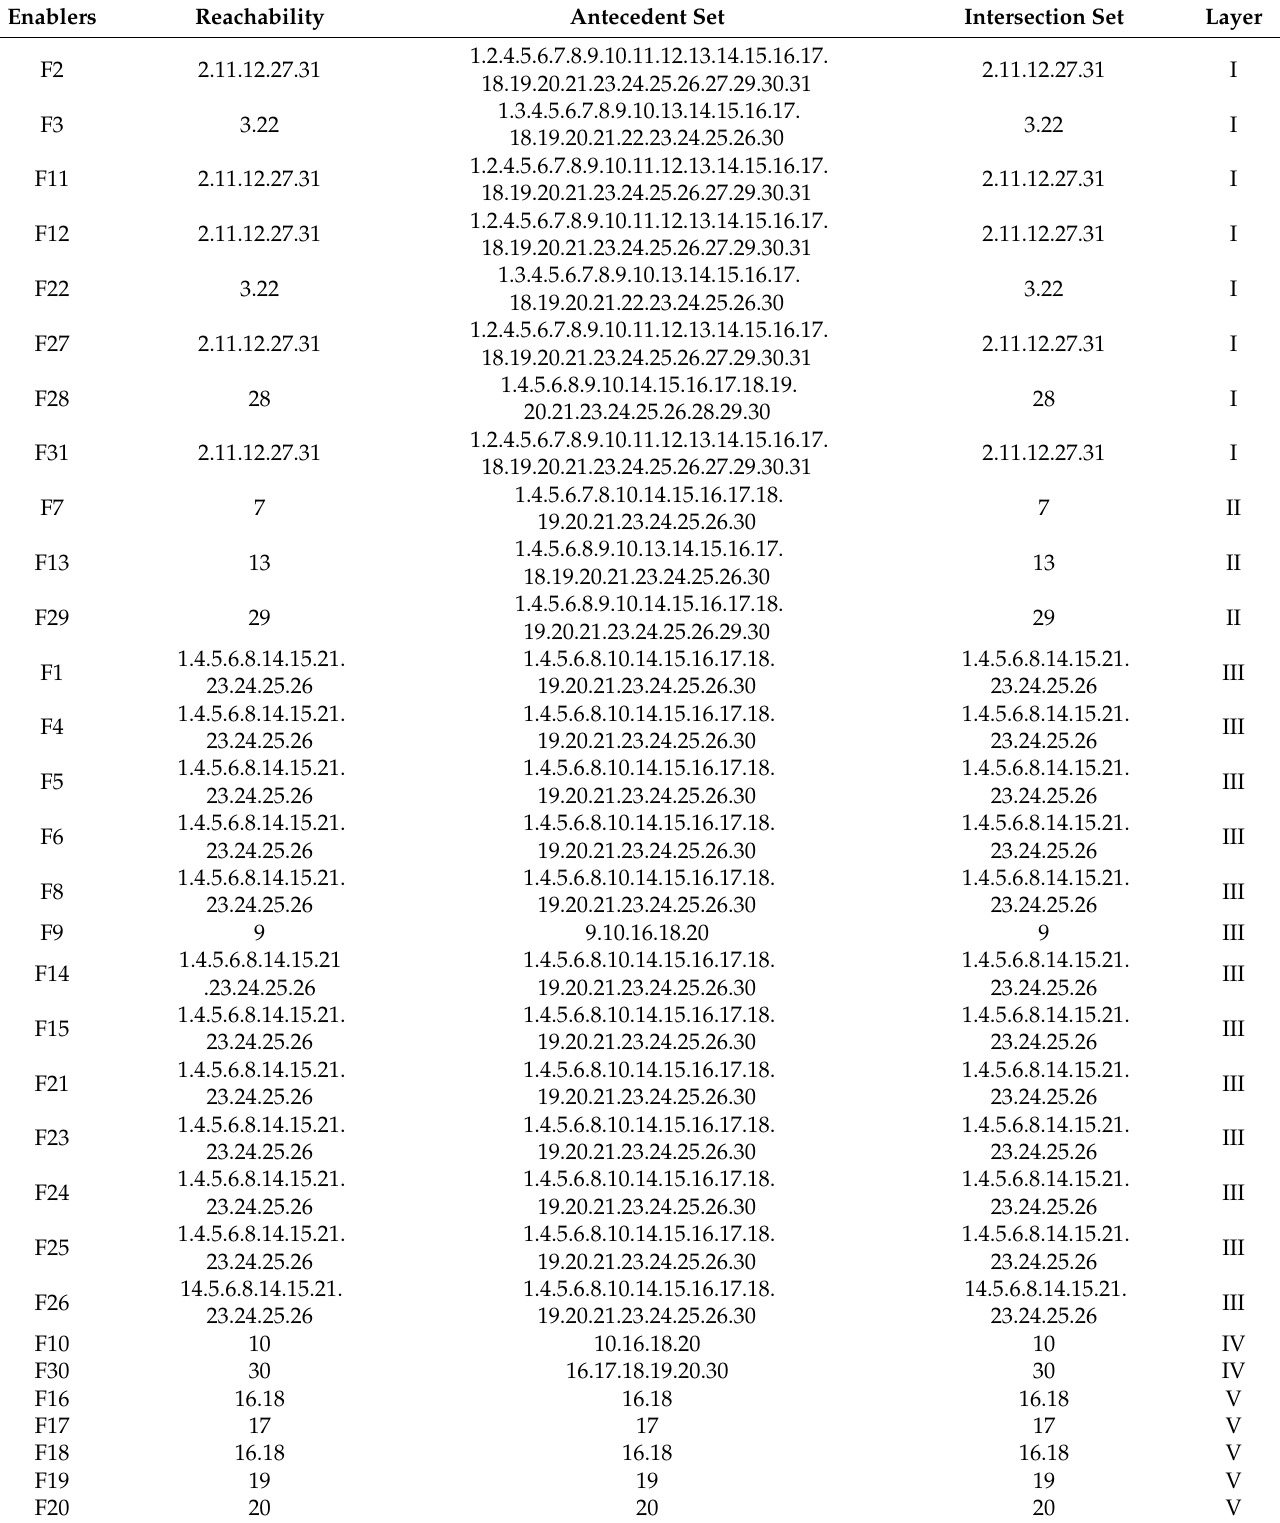
Table 3. Layer partition of reachability matrix of